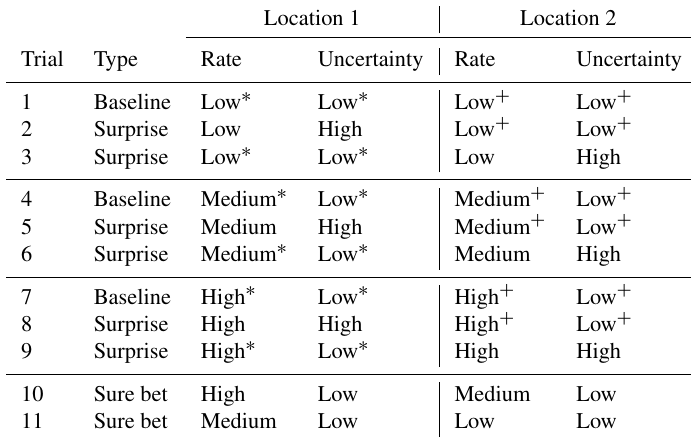
Table 2. Trials in the Comparative Judgment task by type. Two trial types correspond to UV communication goals. Participants had to judge which of the two locations will have more aftershocks in the next week, given the forecast map(s). For each rate level, locations marked with an asterisk/plus sign were identical between the baseline and surprise trials, meaning that only the other location was moved to create a surprise